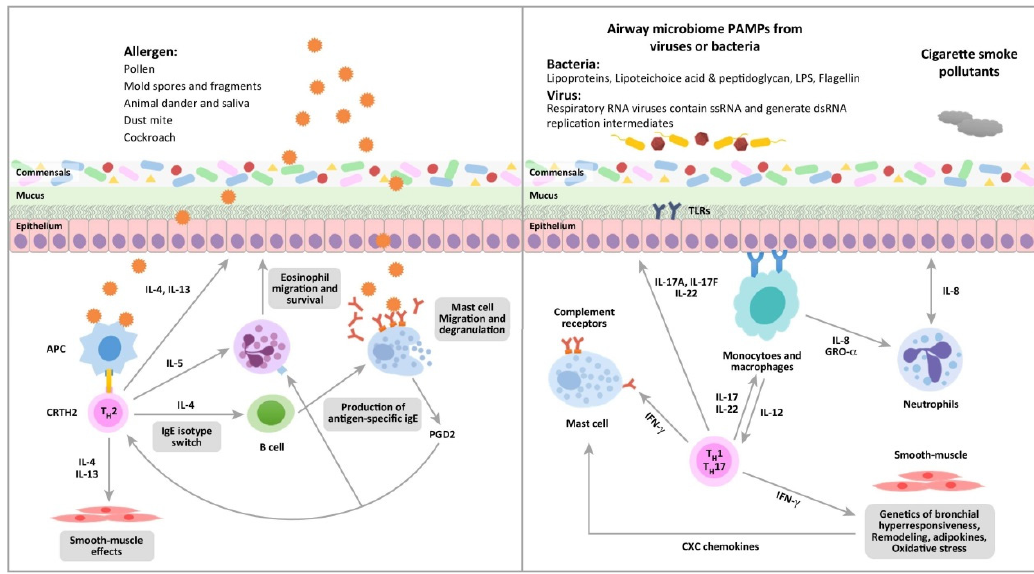
Figure 1. The diagram shows potential triggers and innate immune response of eosinophils. Respiratory infections caused by bacterial and viral infections activate structural and immune cells, cause inflammation, and affect reactions to other allergens, pathogens, and pollution. Adapted from [22], Elsevier, 2015.